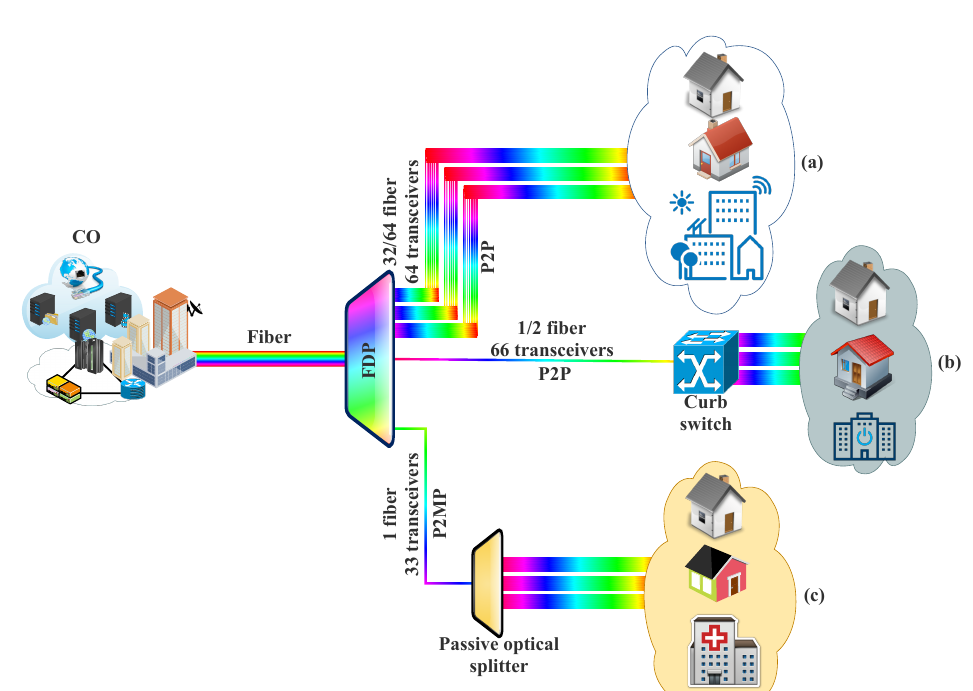
Figure 23. Potential Ethernet solutions: ( a ) PtP Ethernet, ( b ) curb-switched Ethernet, and ( c )